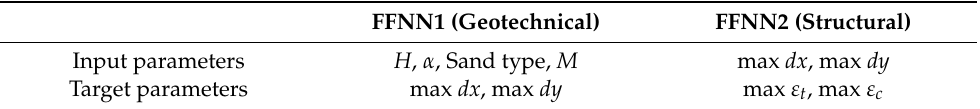
Table 2. Input and target parameters of the developed FFNNs for the two parts of the decou- pled